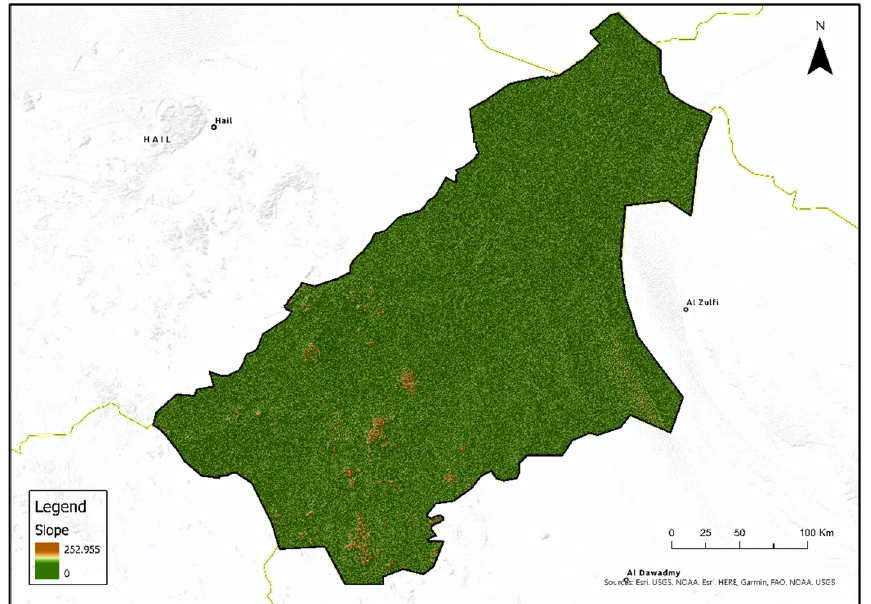
Figure 5. Slope value of the study area derived from